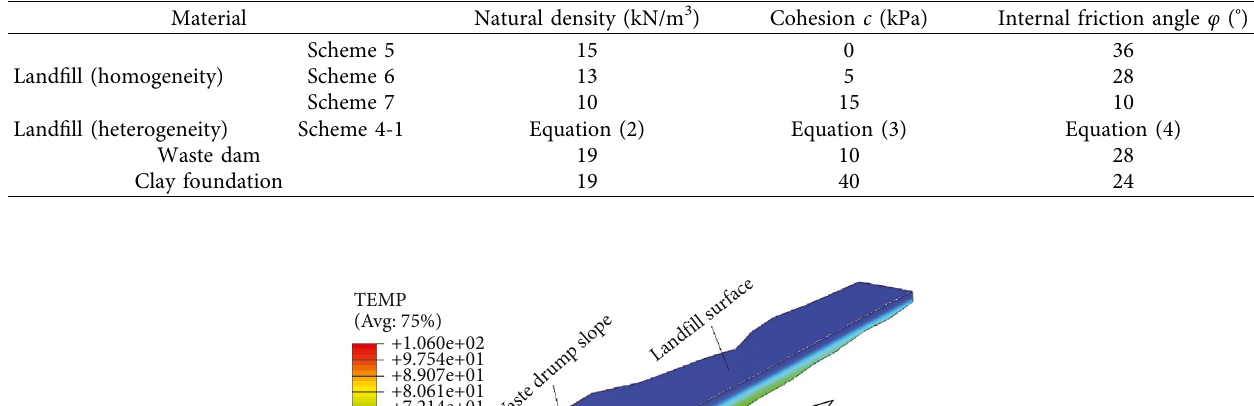
Table 5: Reference values for engineering properties of the landfill site.